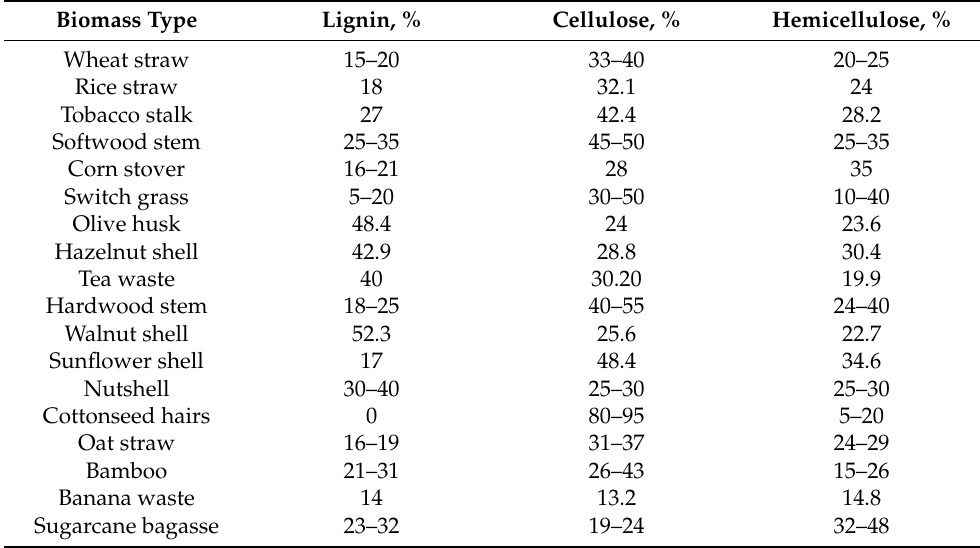
Table 5. Cellulose, hemicellulose, and lignin content of some selected biomasses